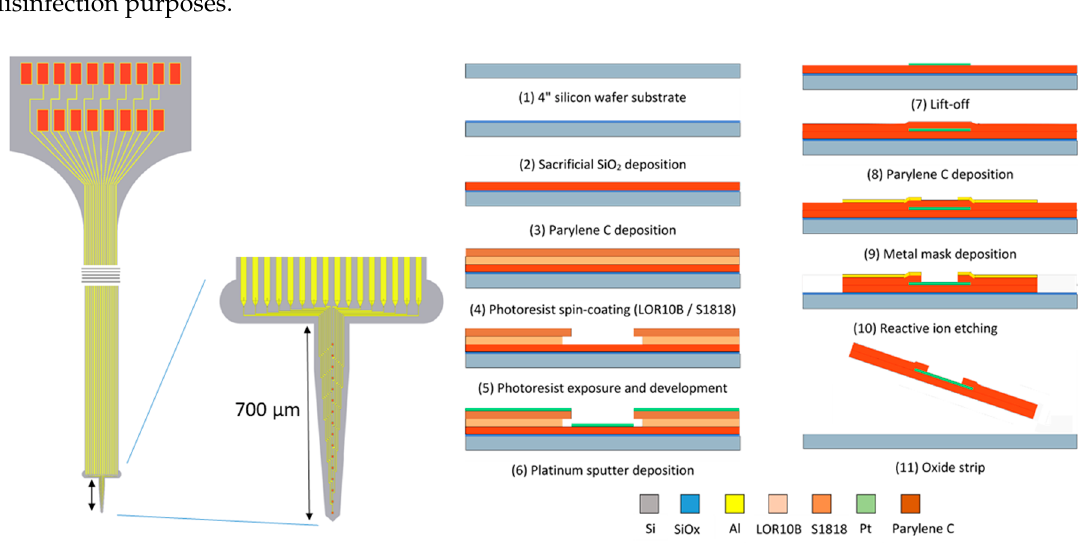
Figure 2. Coating thickness vs. withdrawal speed in function of molecular weight. The error bars represent the standard deviation ( n = 6).